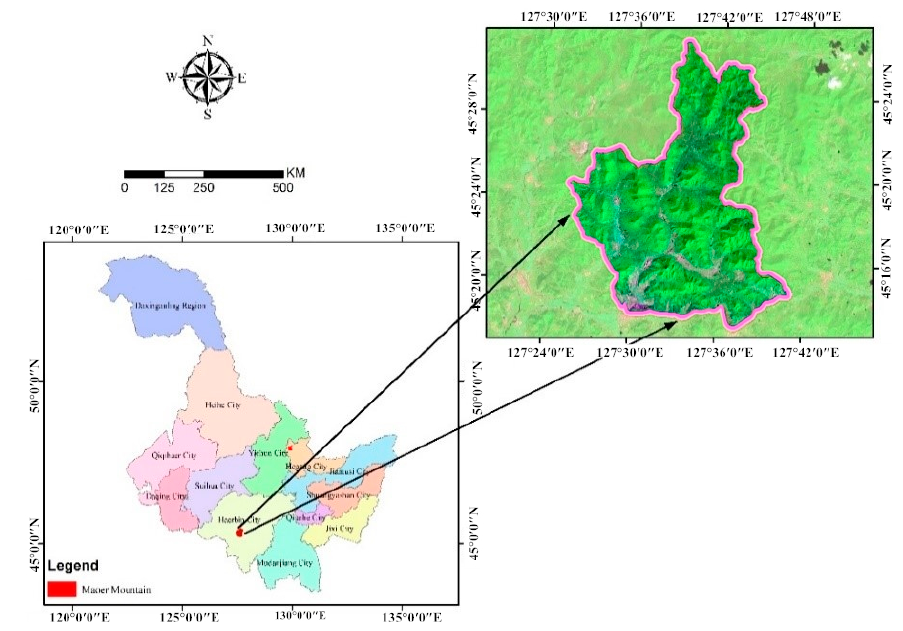
Figure 1. Location of the study site.